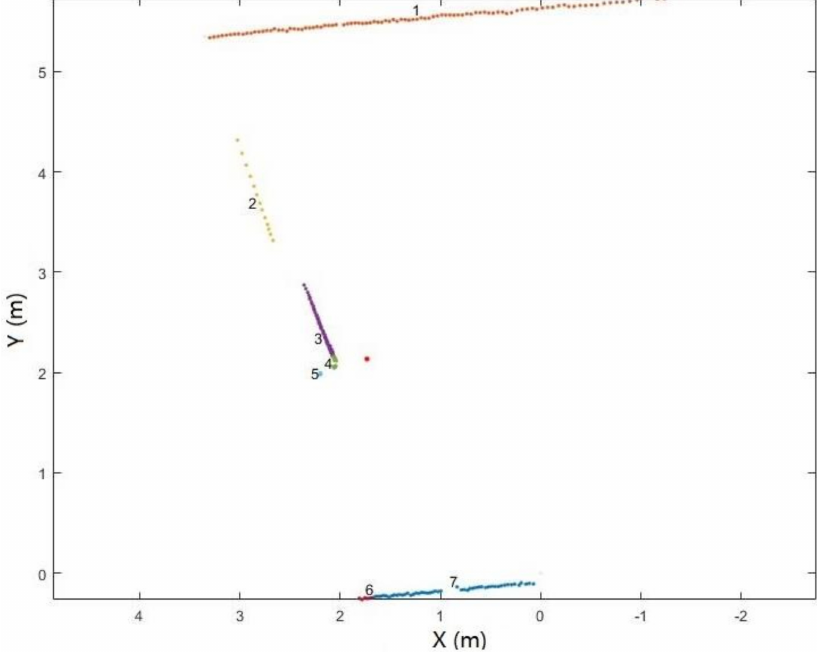
Figure 5. Example of scanline segmentation result (red point: scanner